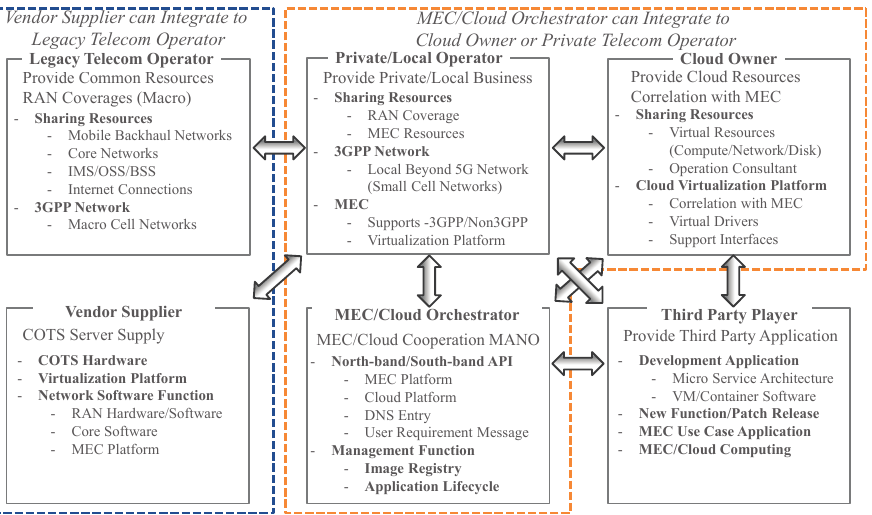
Figure 5. Relationship chart for each